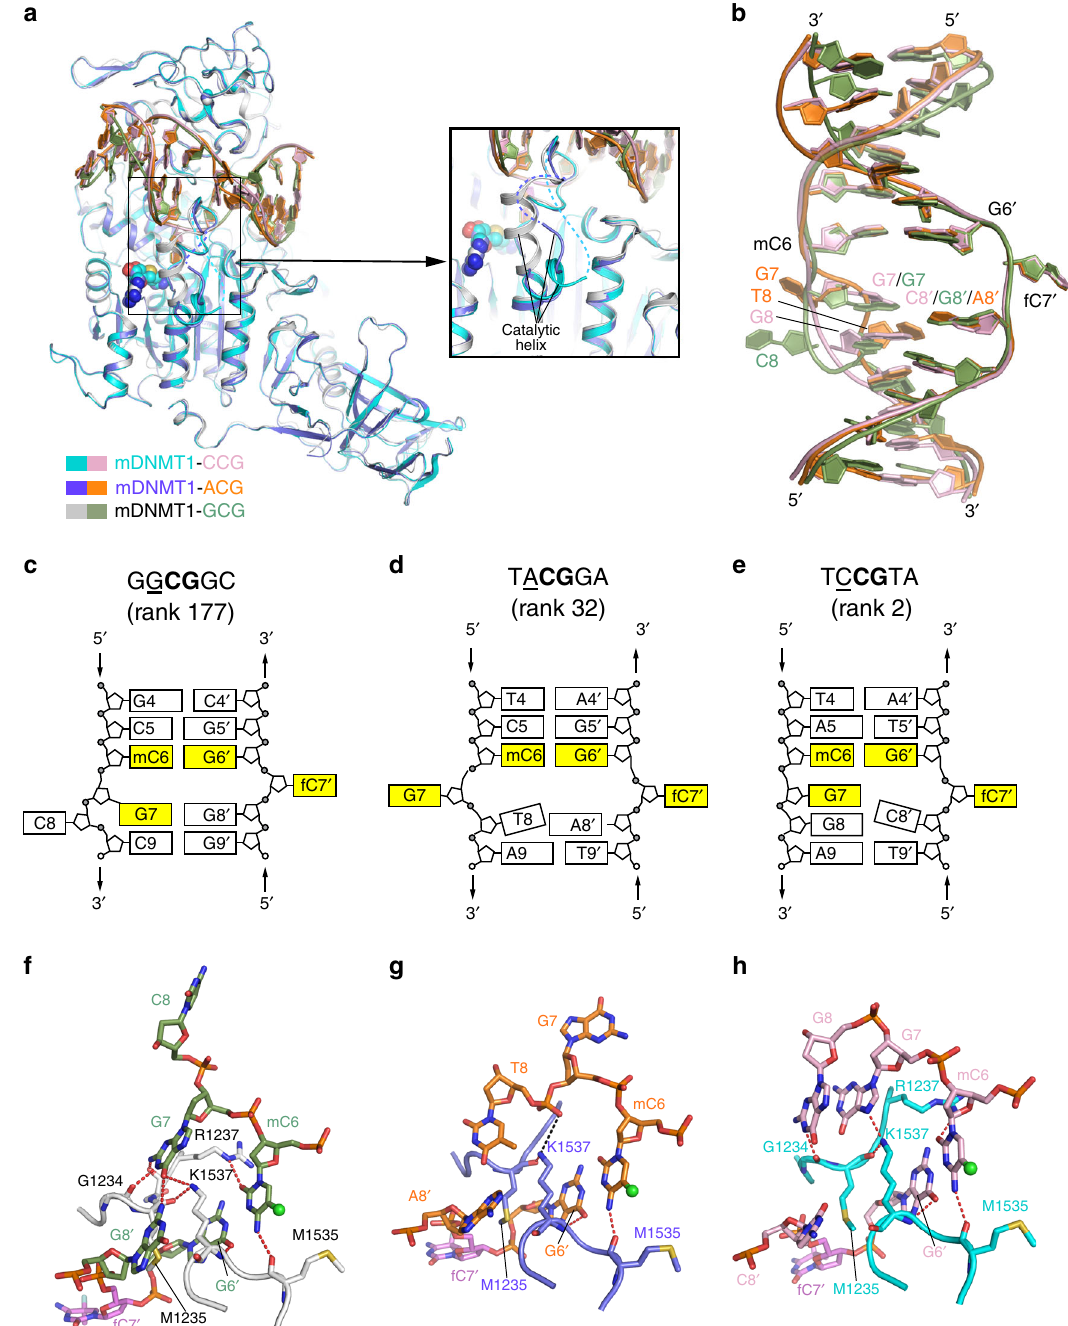
Fig. 4 Structural analysis of the murine DNMT 731 – 1602 -DNA complexes. a Structural overlay of the CCG and ACG complexes (this study) and the GCG complex 17 (PDB 4DA4) with the catalytic helix highlighted in expanded view. The disordered regions N-terminal to the catalytic helix are shown as dashed lines in the respective CCG and ACG complexes. The AdoHcy molecule is shown in sphere representation. b Structural overlay of the CCG DNA, ACG DNA and GCG DNA in DNMT1-bound form. The color scheme is the same as in ( a ). Schematic views of the DNMT1- bound DNAs in the GCG complex ( c ), adopted from a previous report 17 , and ACG ( d ) and CCG ( e ) complexes. Close-up comparison of the protein-DNA interactions at the CpG sites between the GCG ( f ), ACG ( g ) and CCG ( h ) complexes. The 5-methyl group of the mC6 is shown as green sphere. The hydrogen-bonding and electrostatic interactions are shown as dashed lines in red and black, respectively. Note that in the ACG complex, the side chain of R1237 is non-traceable due to missing electron